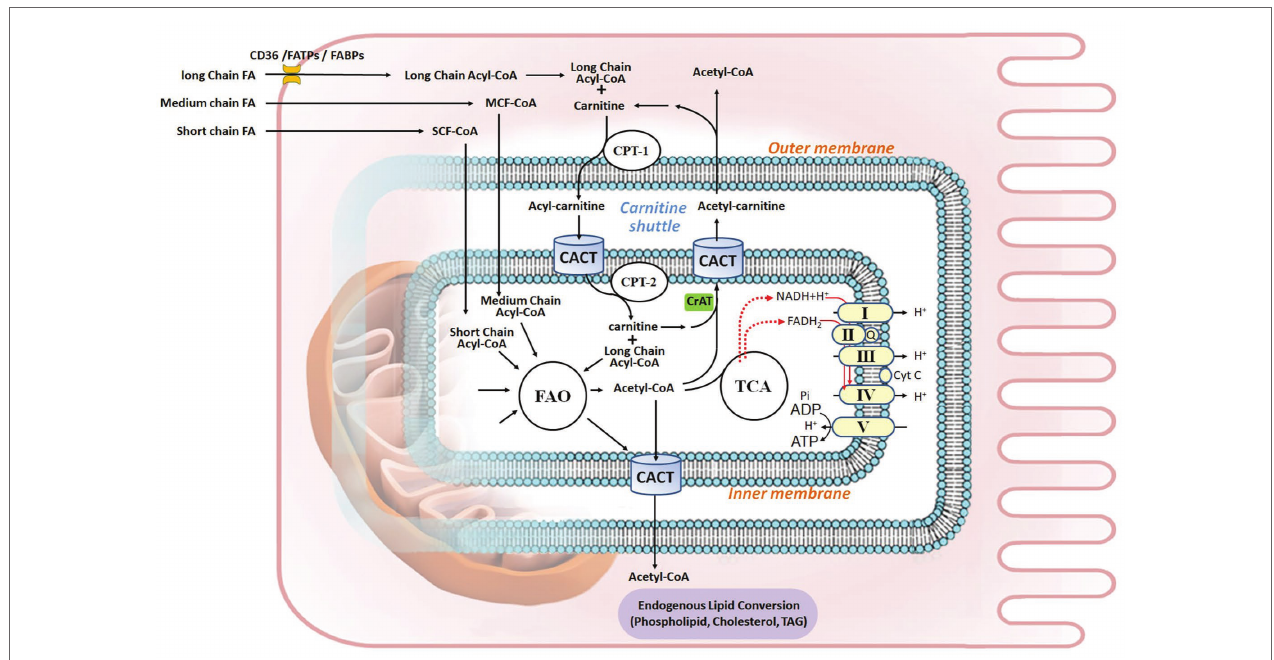
FIGURE 1 | Fatty acid metabolism in renal proximal tubule epithelial cell. Fatty acids (FAs) are the preferred energy substrates for the kidney. Uptake of FAs from capillaries into kidney cells is facilitated by either FAT/CD36 or FABPs and FATPs. In the cytosol, FAs are activated to acyl-CoA, esterified with carnitine, and transported into the mitochondrial matrix through the carnitine shuttle, which is composed of CPT-1, CACT, and CPT-2. Medium-chain FAs and short-chain FAs can permeate the mitochondrial membranes. In the matrix, acyl-CoA undergoes FA β -oxidation (FAO), thereby generating acetyl-CoA to fuel the TCA cycle, as well as FADH 2 and NADH that serve as electron donors to the five ETC complex for ATP production via oxidative phosphorylation. Acetyl-CoA can be shuttled out of mitochondria through carnitine acetyltransferase (CrAT), while it goes through integrated endogenous lipid conversion to form phospholipids, cholesterol, and triacylglycerol (TAG). Q, Coenzyme Q; Cyt C, cytochrome